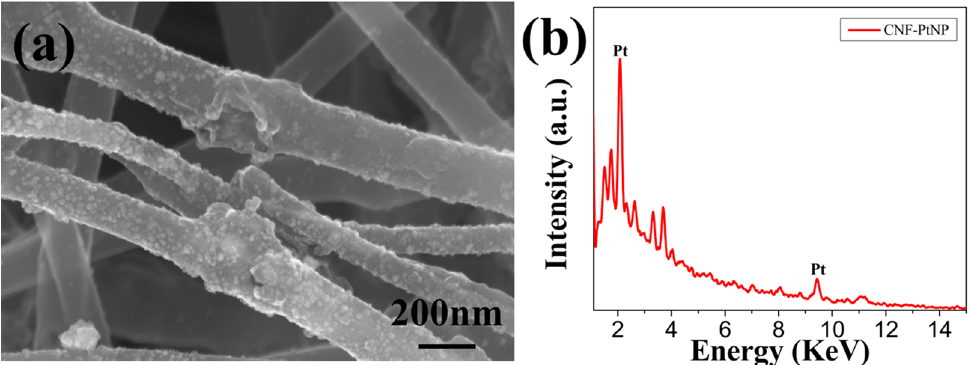
Figure 5. ( a ) Typical SEM image of the fabricated nanoporous CNF-PtNP hybrids; ( b ) Energy-dispersive X-ray (EDX) spectra of the fabricated nanoporous CNF-PtNP hybrids. To identify the existence of PtNPs in the created CNFs, X-ray photoelectron spectroscopy (XPS) was performed firstly. Figure 6a shows the obtained XPS spectrum of the decorated CNFs from 0 to 700 eV. Four different peaks are observed, corresponding to the elemental Pt, C, N and O, respectively. Obviously, the existence of N (9.14%) is the remnant of PAN during the carbonization [45]. To make the peaks of Pt more distinguishable, we carried another XPS analysis with an abscissa from 64 to 80 eV. As a result, two significant characteristic peaks at 71 and 74.3 eV can be seen, which are assigned to the 4f 7/2